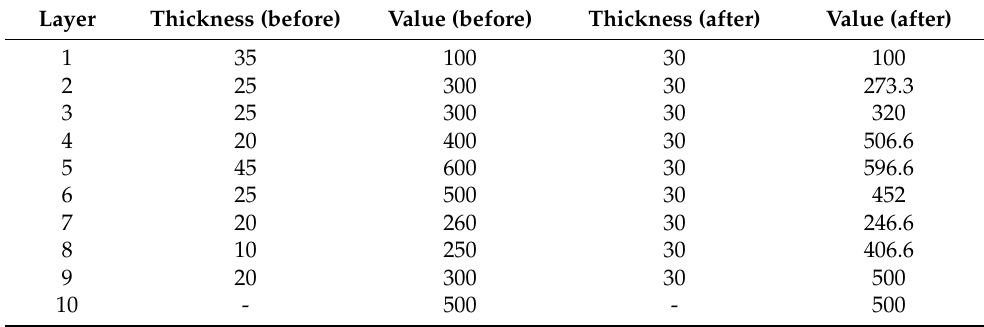
Table 1. Parameters of the original